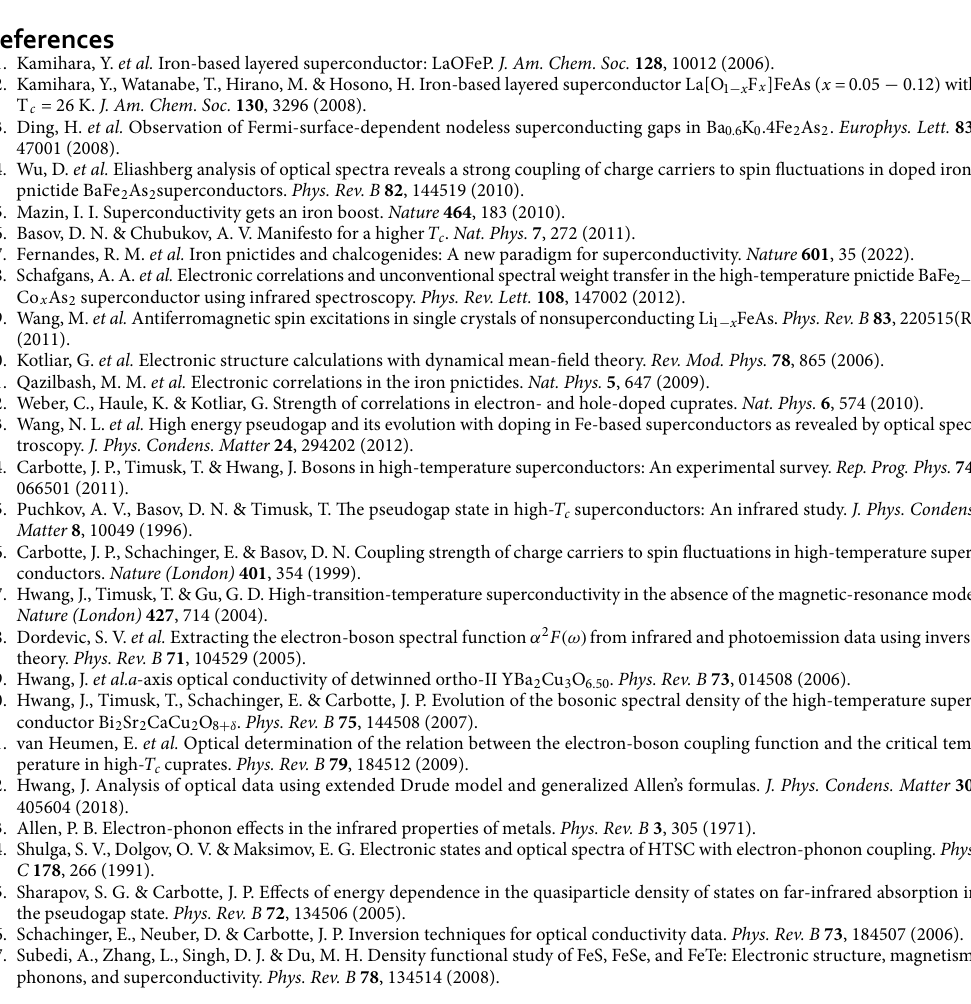
x K x Fe 2 As 2 ). −